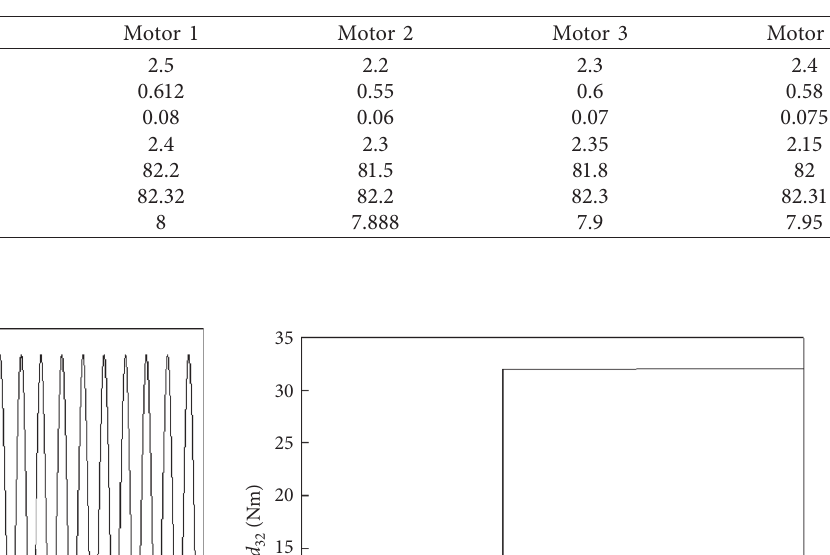
Table 1: Parameters of each